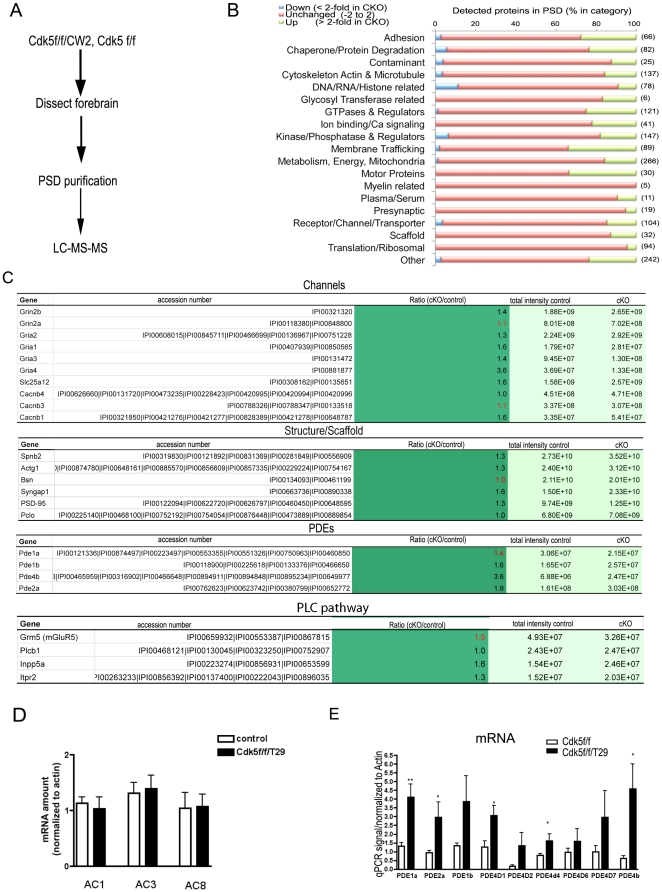
Proteomic analysis of post-synaptic densities reveals changes in PDE proteins in CDK5 mutant mice.
A. Procedure sequence for mass-spectrometry analysis with PSDs from control (Cdk5f/f) and Cdk5f/f/CW2 (cKO) mice. B. Summary of detected protein abundance differences categorized by various protein functions. C. Representative molecules changes detected in Cdk5 cKO mice. Red number indicates reduction folds; black number indicates increase folds. D. RT-qPCR results of ACs in hippocampal CA1 in Cdk5f/f and Cdk5f/f/T29. qPCR signals were normalized to actin in each sample (n = 3). E. RT-qPCR results of PDEs from hippocampal area CA1 in Cdk5f/f and Cdk5f/f/T29.